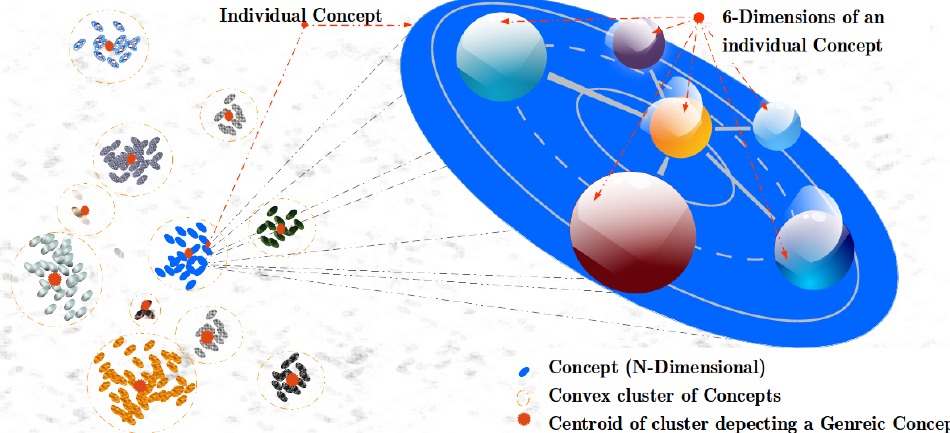
Figure 1. A universe of concepts in six-dimensional feature hyper-space. The ovals in the diagram depict individual concepts. Each individual concept is described by their defining six-dimensions. The cluster of concepts shows the groups formed by similar concepts represented by a convex cluster of concepts, and the cluster centers depicts the most generic concept of the